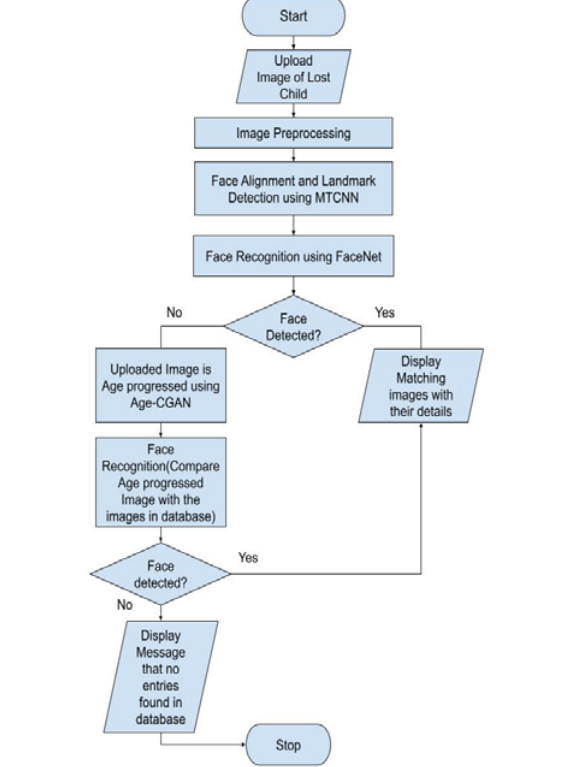
Figure 5. Proposed Flow of the